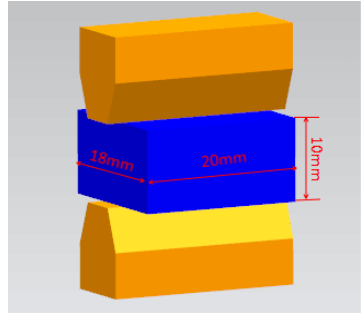
Figure 1. The initial shape and size of the specimens. Table 1. The nominal chemical composition of the 5754 aluminum alloy.